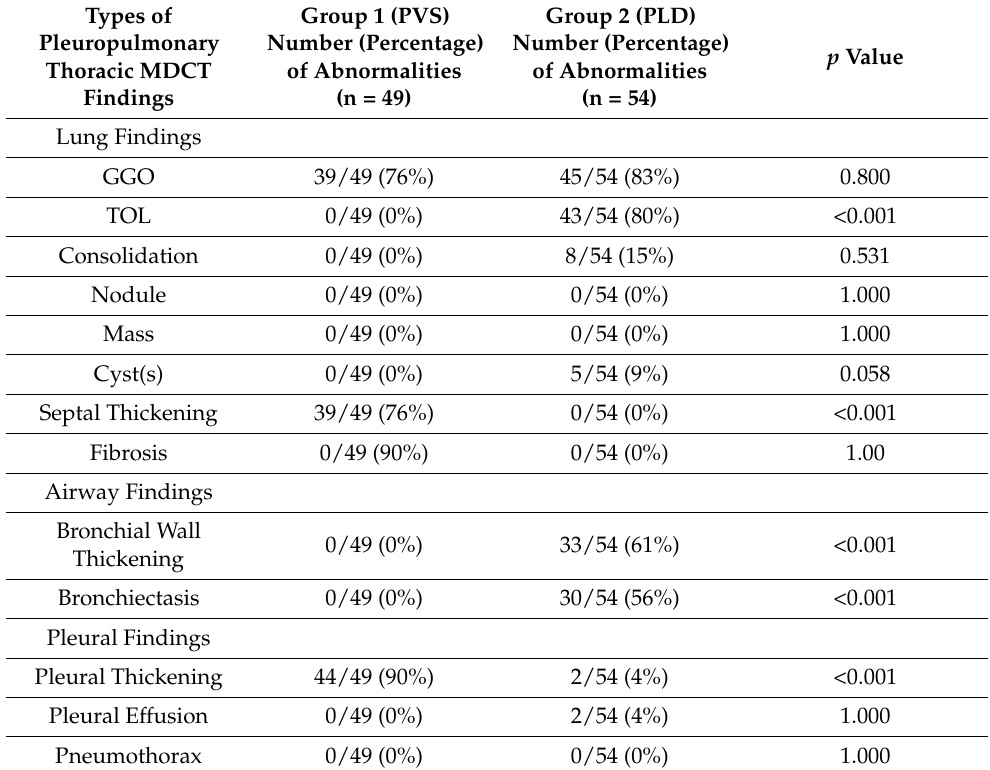
Table 1. Summary of pleuropulmonary thoracic MDCT findings of children with pulmonary vein stenosis (PVS) versus prematurity-related lung disease